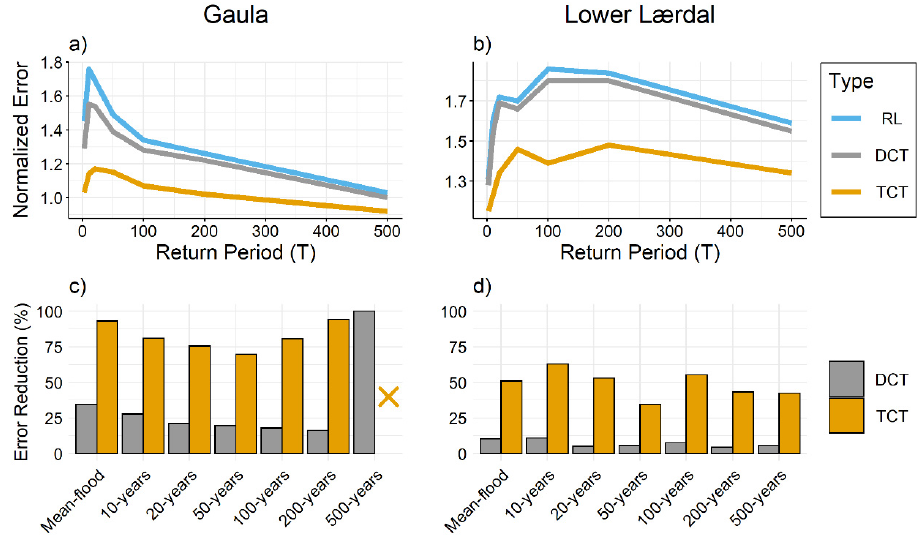
Figure 7. The inundation error for Gaula and Lower Lærdal sites after the terrain correction (TCT) and the discharge correction (DCT) techniques were applied ( a , b ) with the corresponding reduction in error for each scenario ( c , d ). The Error Reduction value in ( c ) for Gaula is omitted due to under-estimation.